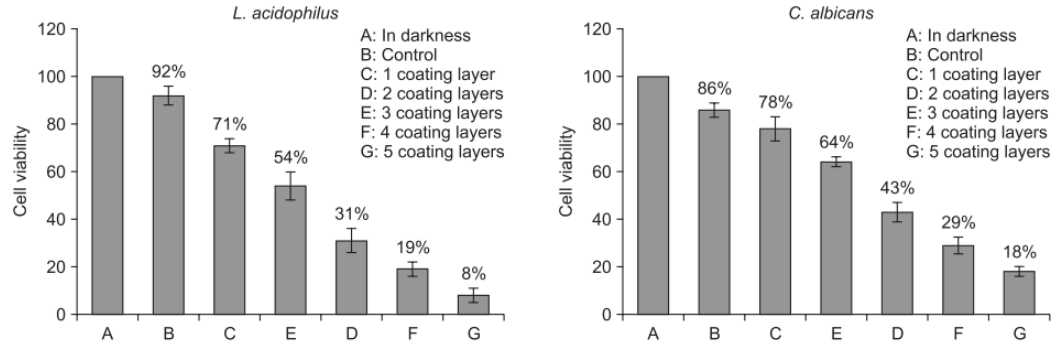
Figure 6. Antibacterial effect of TiO 2 thin film with 1–5 coating layers against Lactobacillus acidophilus and Candida albicans [69].